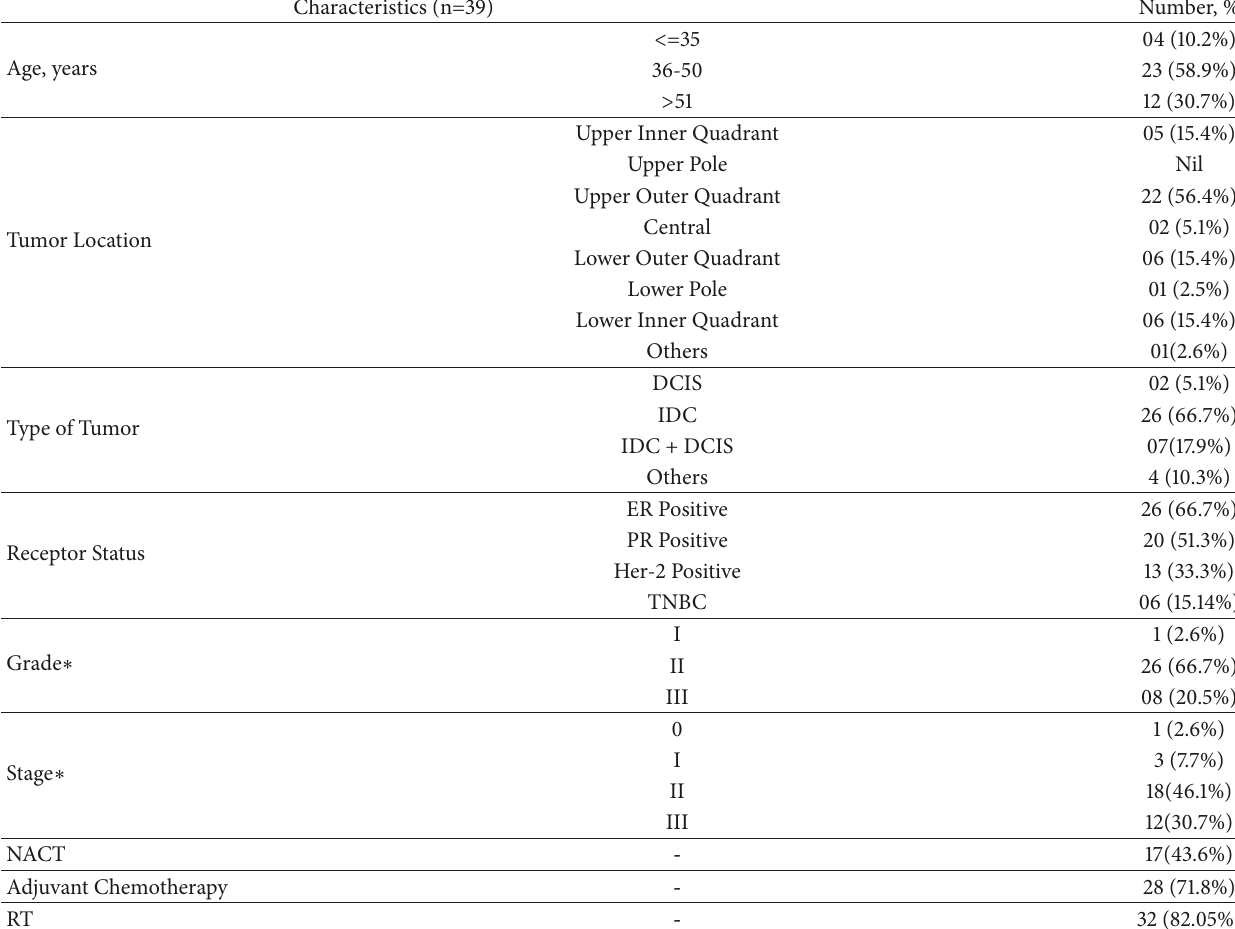
Table 1: Demography and clinicopathological profile of study participants.